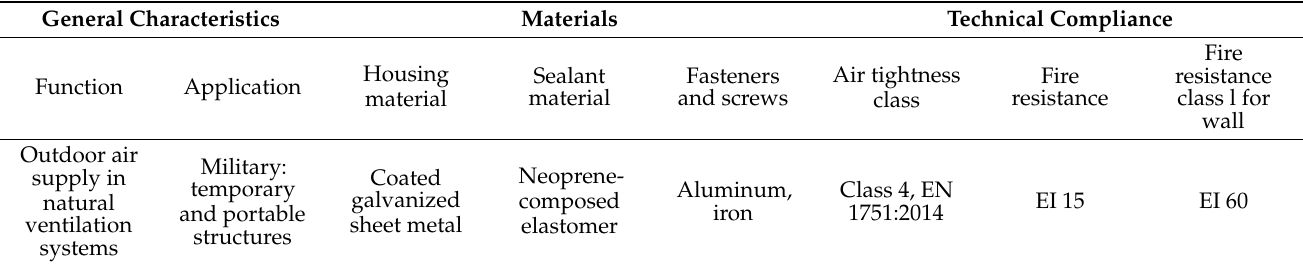
Table 2. Overview of the airtight supply valve